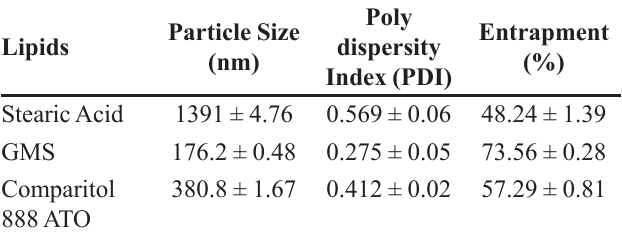
TABLE II - Screening of lipids for SLNs